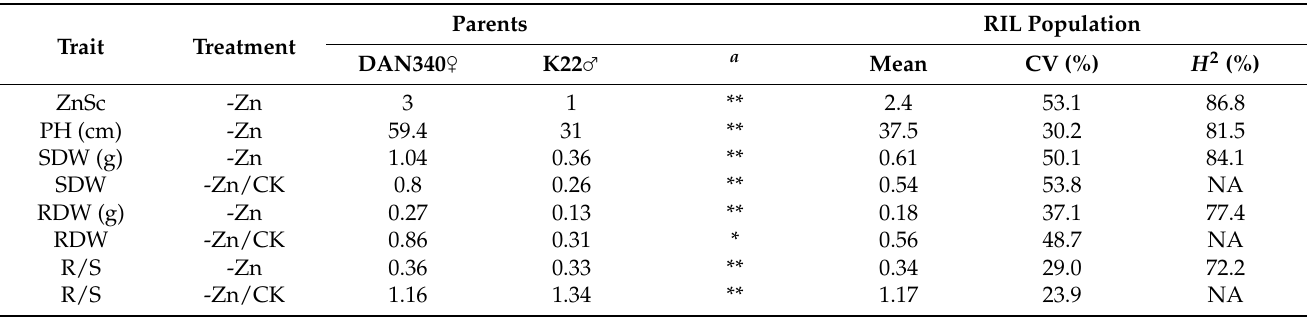
Table 2. Phenotypic variations of the traits associated with Zn deficiency tolerance in the parental lines DAN340 and K22, and DAN340 × K22 RIL